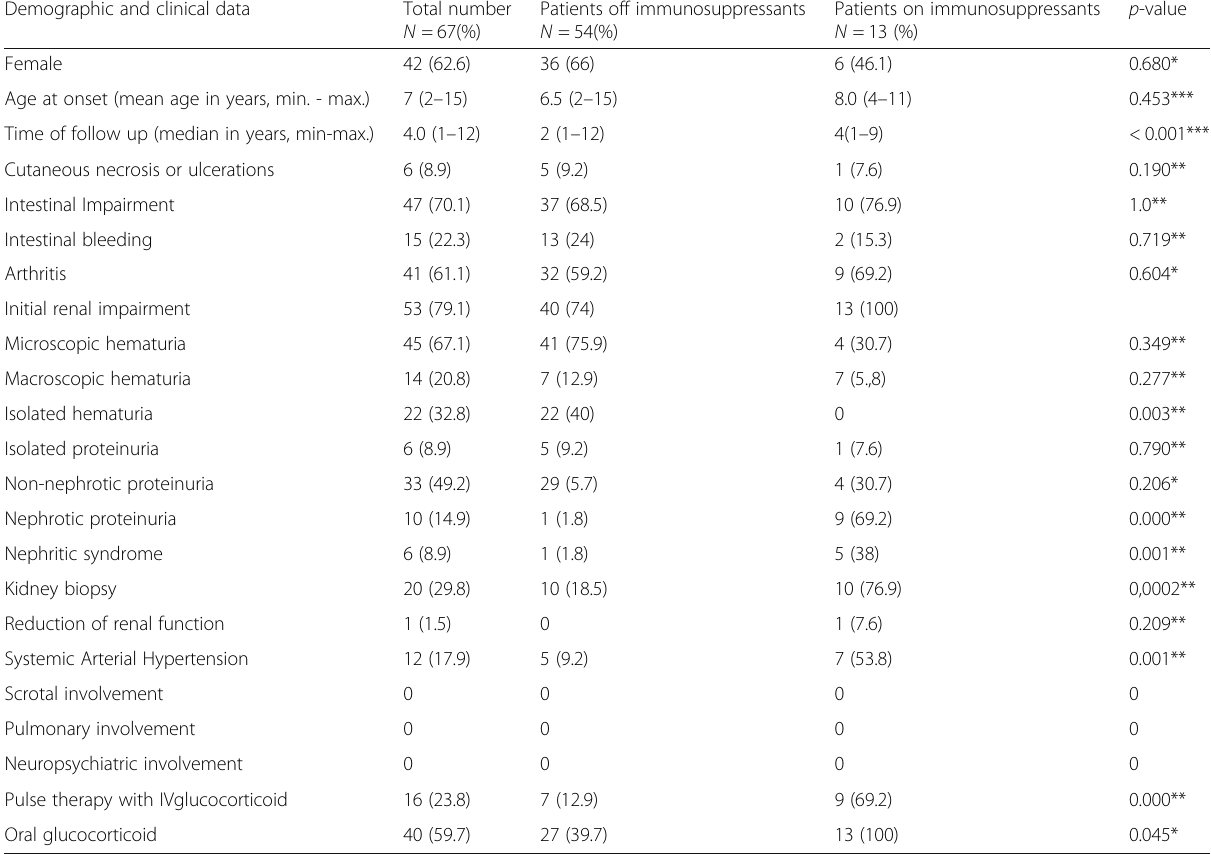
Table 1 Demographic data and clinical manifestations of the 67 patients with nephritis due to Henoch-Schönlein Purpura Demographic and clinical